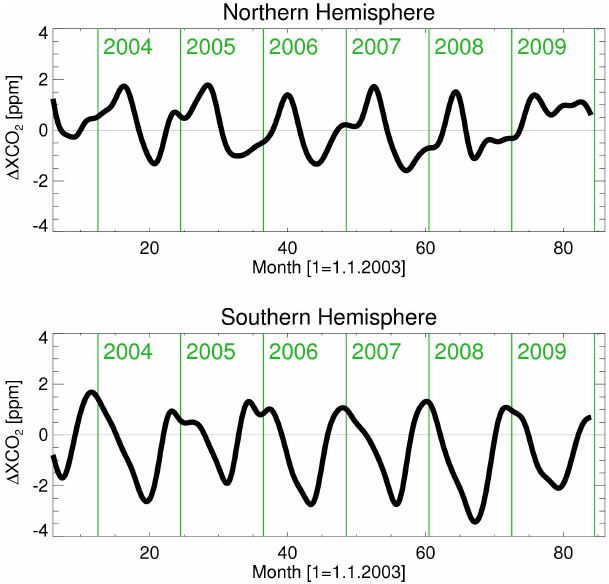
Fig. 5. Difference of the smoothed SCIAMACHY and Carbon- Tracker XCO 2 of Fig. 3 for both